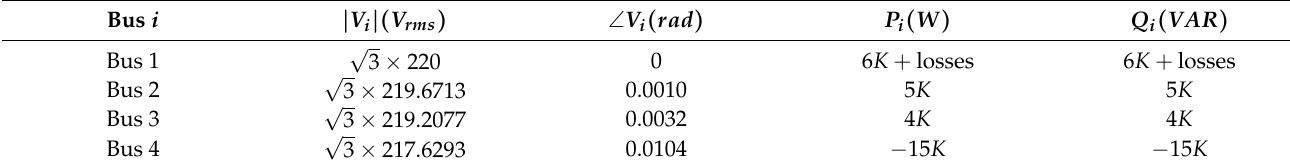
Table 3. Voltage and power details of the microgrid operation for t ≥ 0.1